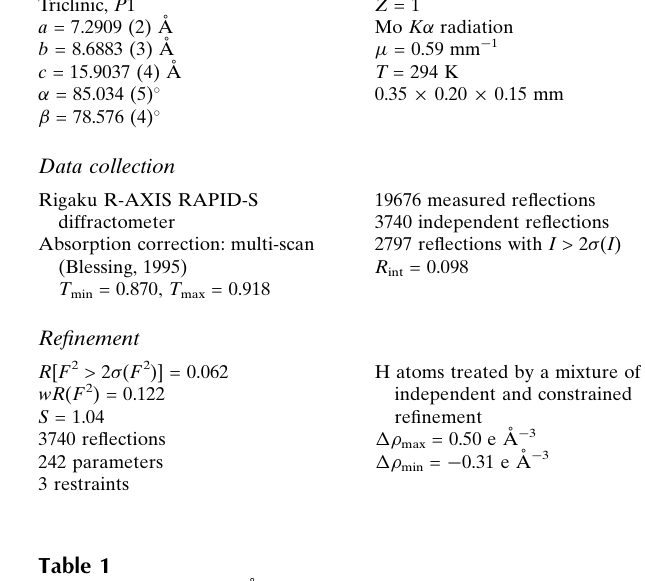
Selected bond lengths (A˚ ).